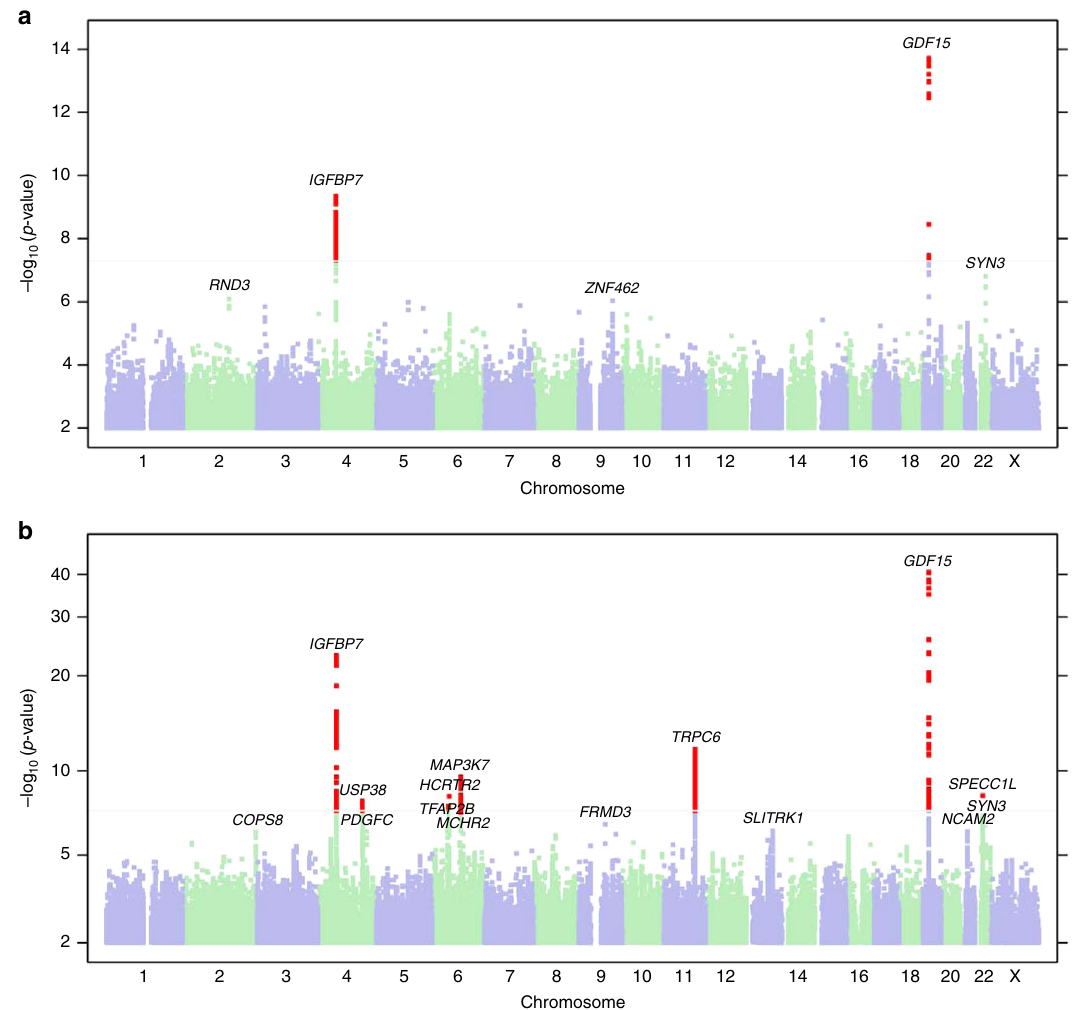
Fig. 1 Genome-wide association scans for nausea and vomiting of pregnancy. The Manhattan plot shows distribution of association test statistics vs. genomic position for a SCAN1 (binary phenotype), and b SCAN2 (ordinal phenotype). The Manhattan plot shows distribution of association test statistics versus genomic position. Chromosomes are arranged along the X -axis. Log10-scaled p -values are shown on the Y -axis. The loci with positions with p < 5 × 10 − 8 are shown in red and the loci with p < 10 − 6 are labeled with names of nearest genes